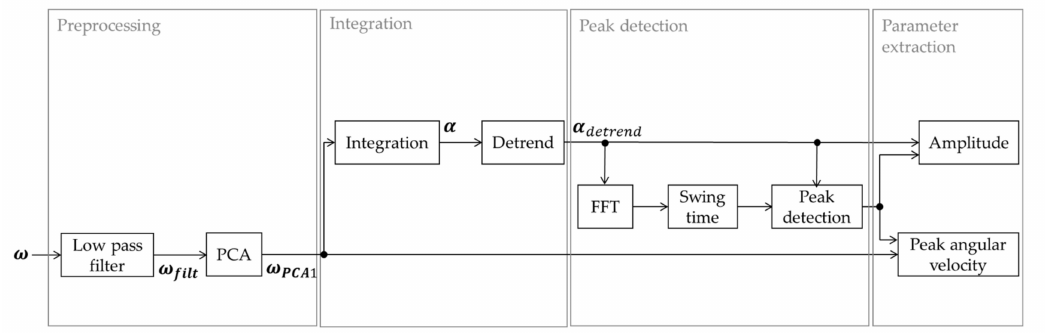
Figure 2. Block diagram of the arm swing